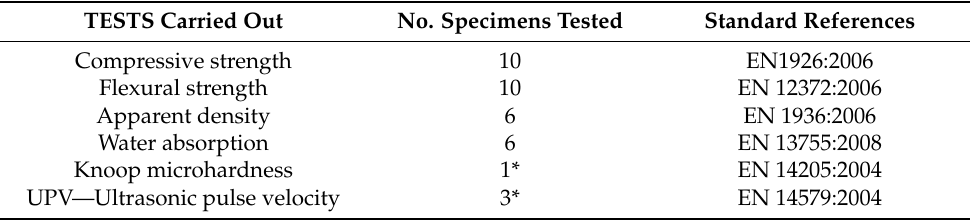
Table 2. Tests carried out with number of specimens for each stone tested and the relative reference standards.